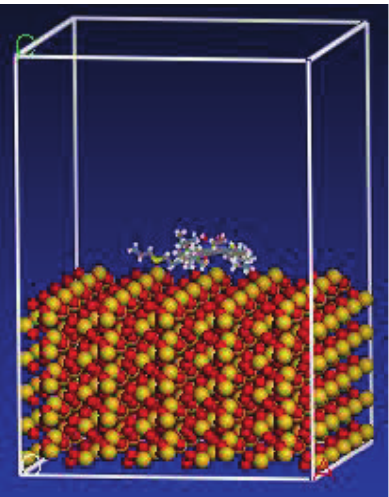
Figure 7: Asphaltene/SiO 2 interface model.